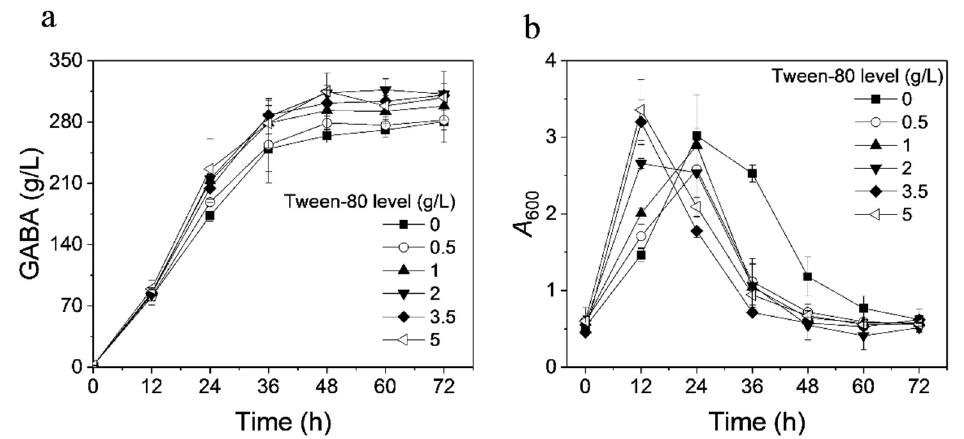
Figure 4. The effect of Tween-80 on ( a ) GABA production and ( b ) cell growth. This was evaluated using a 250 mL Erlenmeyer fermentation flask at 32.0 °C. Cell growth was expressed as A 600 . Vertical bars represent standard deviations of means ( n = 3). There was no significant difference in 48 h GABA concentration between 5 g/L and 2 ( p = 1.000), 3.5 ( p = 0.907), 1 ( p = 0.587), or 0.5 g/L of Tween-80 ( p = 0.143), but there was a significant difference between 5 and 0 g/L of Tween-80 ( p = 0.024). GABA, gamma-aminobutyric acid; A 600 , absorbance at 600 nm.